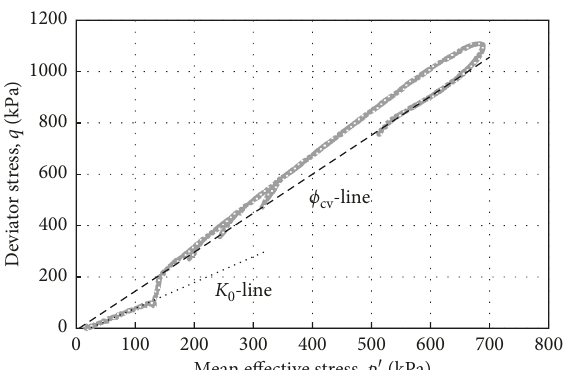
Figure 11: Relationship between K